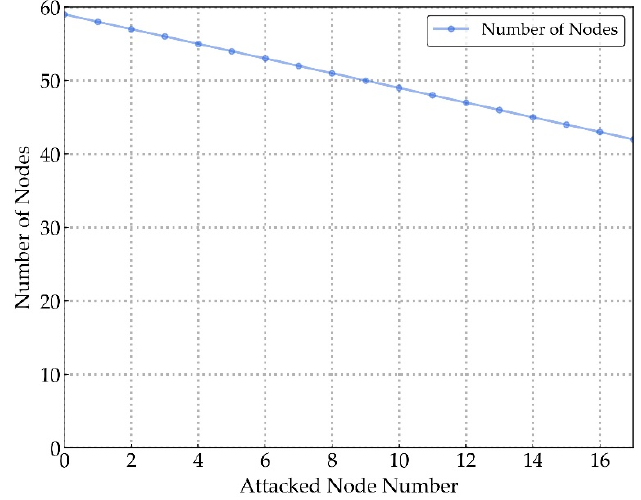
Figure 4. Number of nodes of the attacked NQPB.